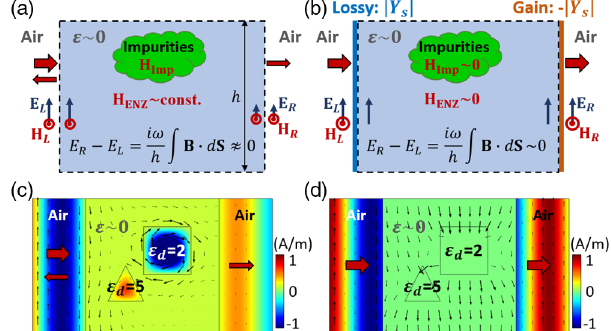
FIG. 6. (a,b) Schematic graphs of the electric- and magnetic- field analysis for (a) the doping model without PT -symmetric metasurfaces and (b) the impurity-immunity model with PT - symmetric metasurfaces. The dashed lines denote the integral area for the calculation of magnetic flux. (c,d) The distributions of calculated electric fields (arrows) and magnetic fields (color) for the doping model and the impurity-immunity model with PT - symmetric metasurfaces, respectively. A triangular impurity of ε ¼ 5 and a square impurity of ε ¼ 2 exist in both d d